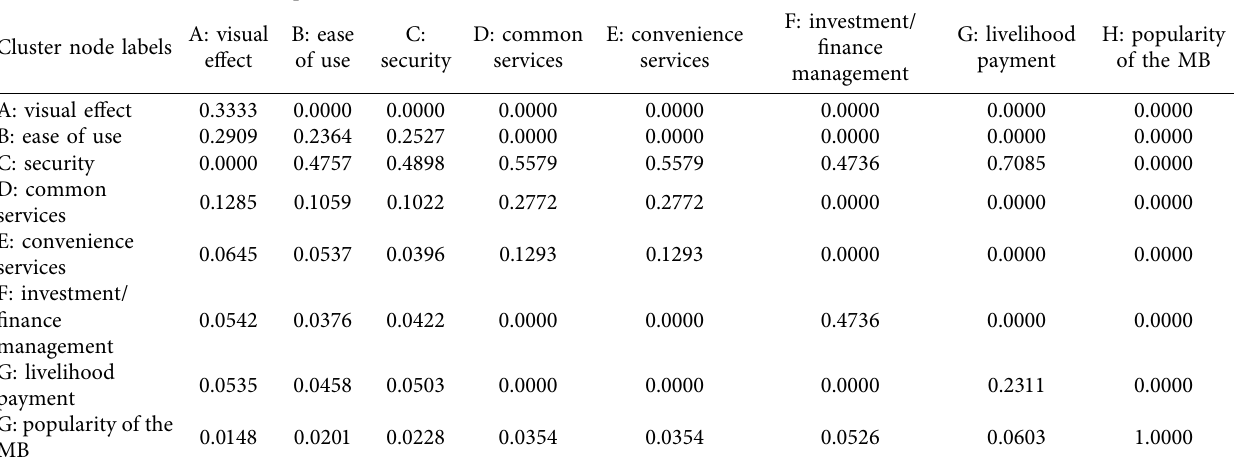
Table 20: The pairwise comparison